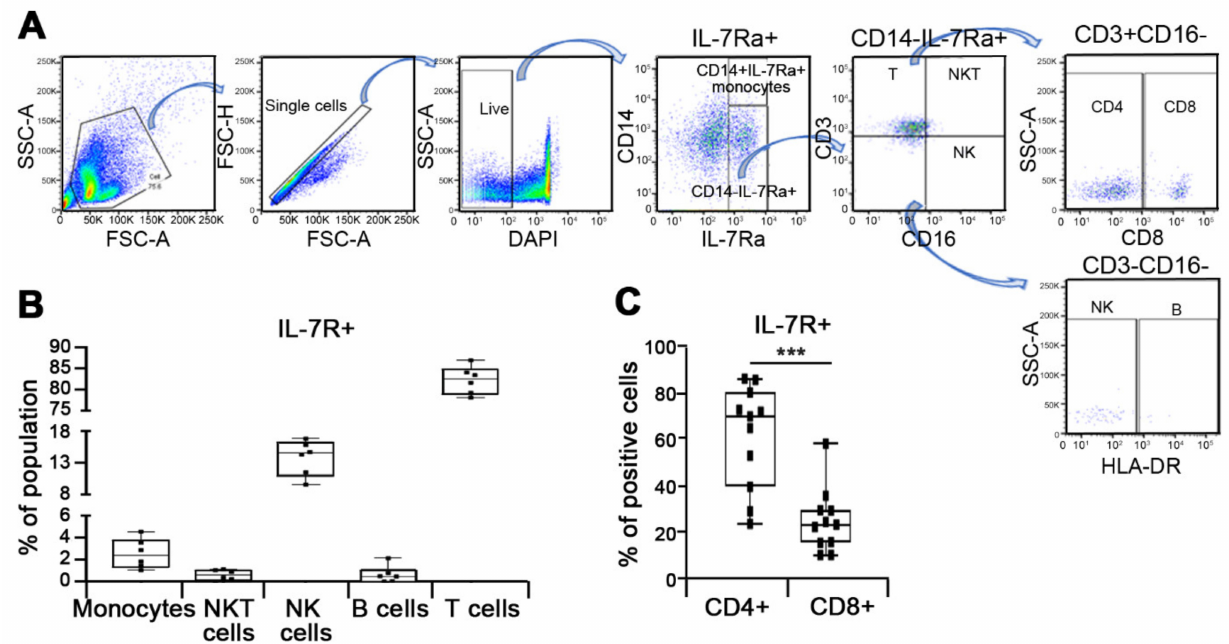
Figure 3. Prominent expression of IL-7Ra in T lymphocytes. ( A ) Representative gating strategy for identification of IL-7Ra expressing cells based on expression of immune cell markers including CD3, CD8, CD14, CD16 and HLA-DR to define monocytes, natural killer T (NKT) cells, natural killer (NK) cells, B lymphocytes, and T lymphocytes in PBMCs. ( B ) PBMC were isolated from pancreatic cancer patients ( n = 6). The percentage of IL-7R positive (IL-7R+) cells was determined utilizing flow cytometry analysis in monocytes, NK cells, NKT cells, T lymphocytes, and B lymphocytes. ( C ) The percentage of IL-7R+ cells among CD4+ or CD8+ cells from pancreatic cancer patients ( n = 11) was evaluated by flow cytometry analysis. *** p < 0.001 versus CD4+ (mean ±